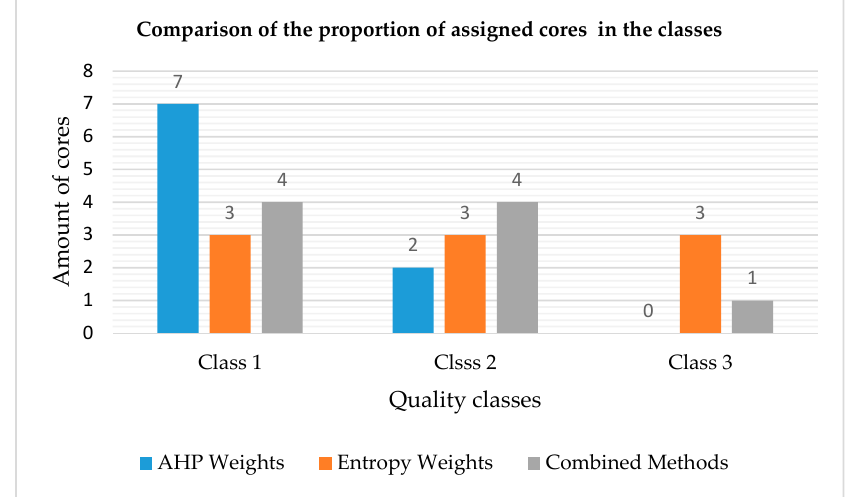
Figure 8. Impact of the weighting methods on the core assignment results.